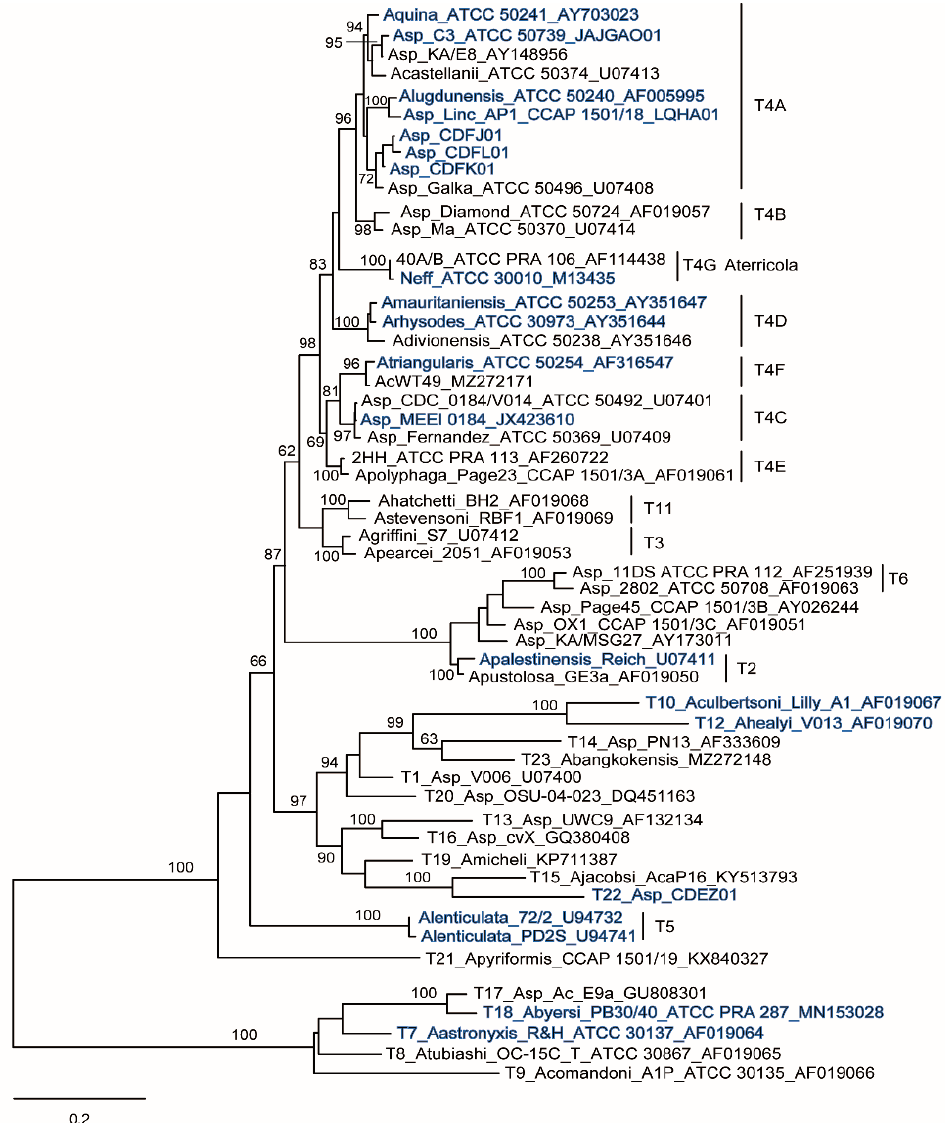
Figure 2. The 18S rDNA phylogeny. Maximum likelihood tree (1000 bootstraps) based on complete 18S rDNA sequences including representatives of all Acanthamoeba genotypes, rooted on members of morphological group 1. Strains analysed herein are highlighted in blue.